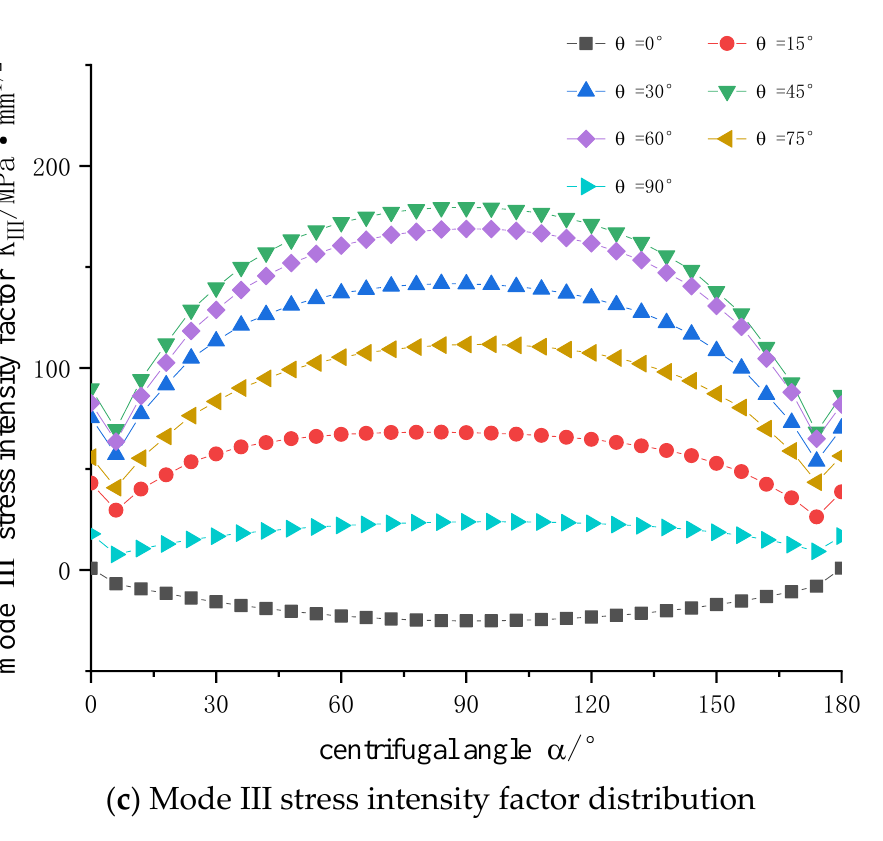
Figure 7. Three modes stress intensity factor distributions: ( a ) Mode I stress intensity factor distri- bution ( b ) Mode II stress intensity factor distribution ( c ) Mode III stress intensity factor distribution.